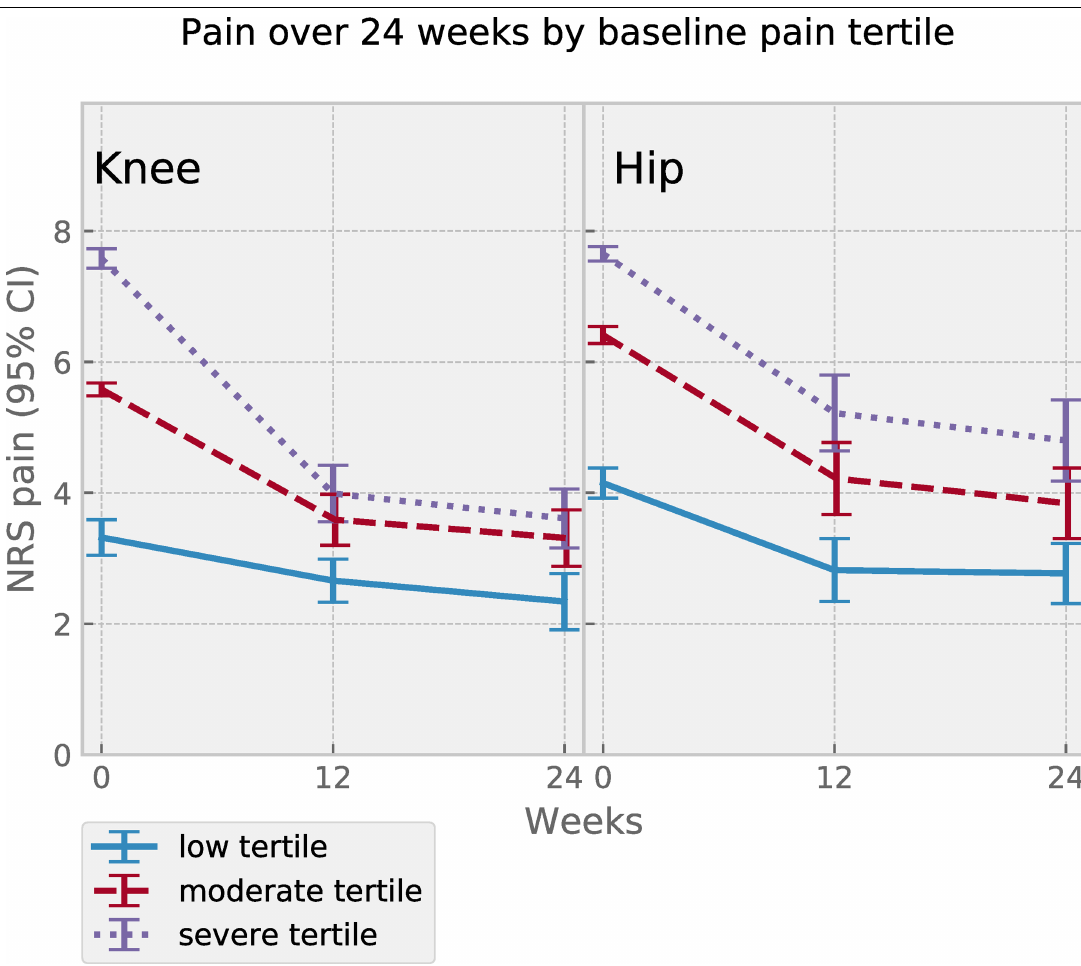
Fig 3. Joint pain change over 24 weeks stratified in tertiles by baseline pain severity for the 0 to 24-week subgroup of patients. Symbols show mean pain value at 0, 12 and 24 weeks for patient subgroups with index joint knee (n for tertiles low 100, mid 99, high 102) or hip (n for tertiles each 66). Error bars represent 95% confidence